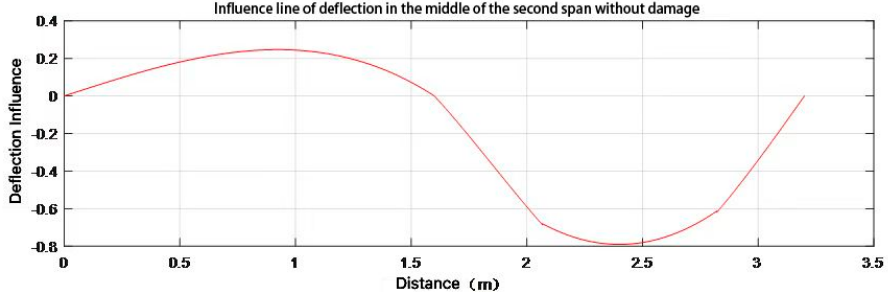
Figure 5. Fitting image of no loss deflection influence line.